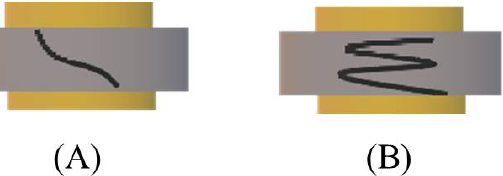
Figure 4. Representation of wave behavior inside the QCR for ( A ) fundamental frequency, and ( B ) the third harmonic.